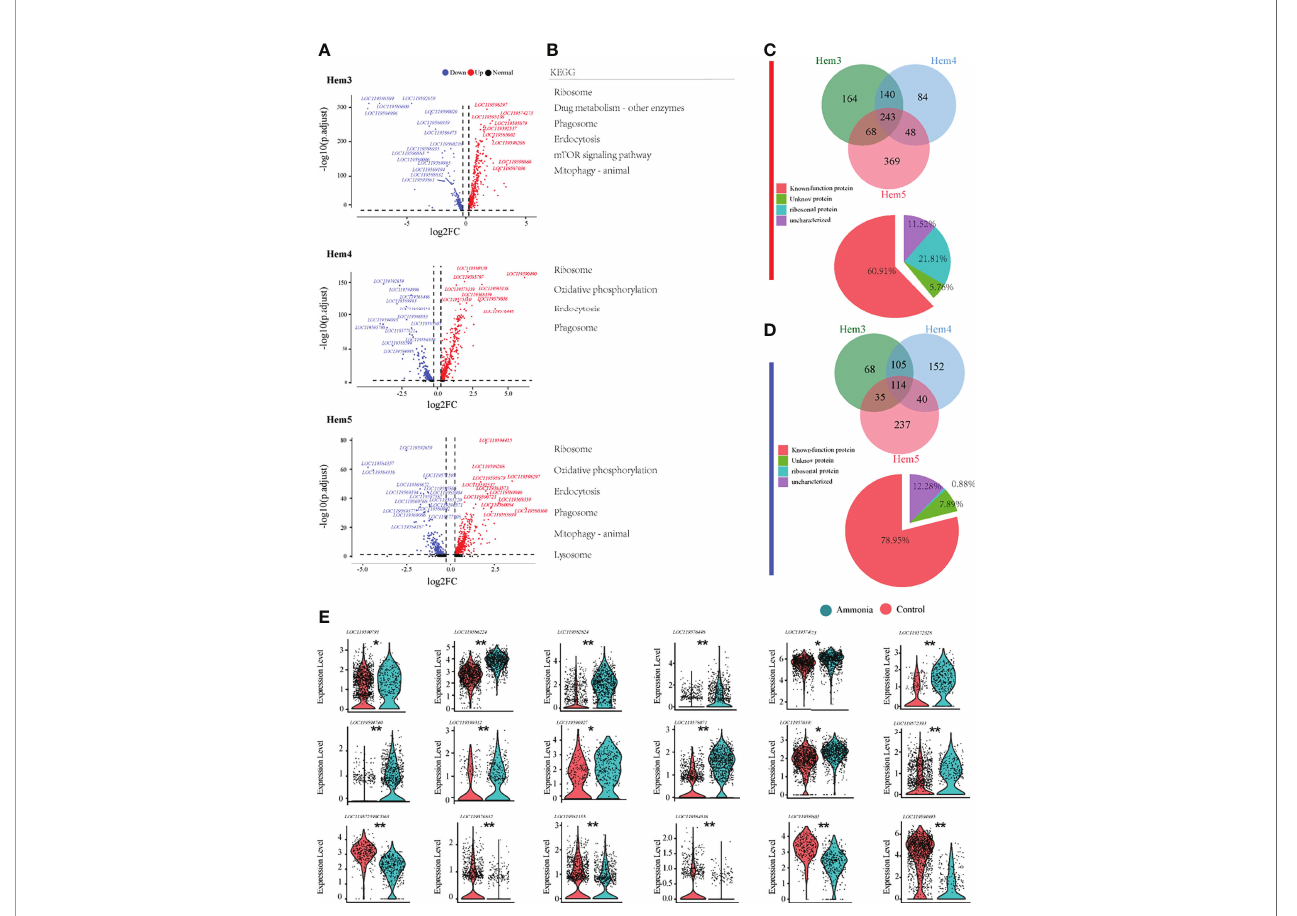
FIGURE 4 | Enrichment analysis of differentially expressed genes in P. monodon haemocytes under ammonia-stress. (A) Differential gene volcanic map display of Hem3/4/5 clusters in haemocytes. (B) KEGG enrichment analysis of differential genes in Hem3/4/5 clusters of haemocytes. (C) The Venn diagram of coupregulated genes and its gene function in haemocytes. (D) The Venn diagram of codownregulated genes and its gene function in haemocytes. (E) Violin diagram showing functional genes in haemocytes. (*p < 0.05 and **P <